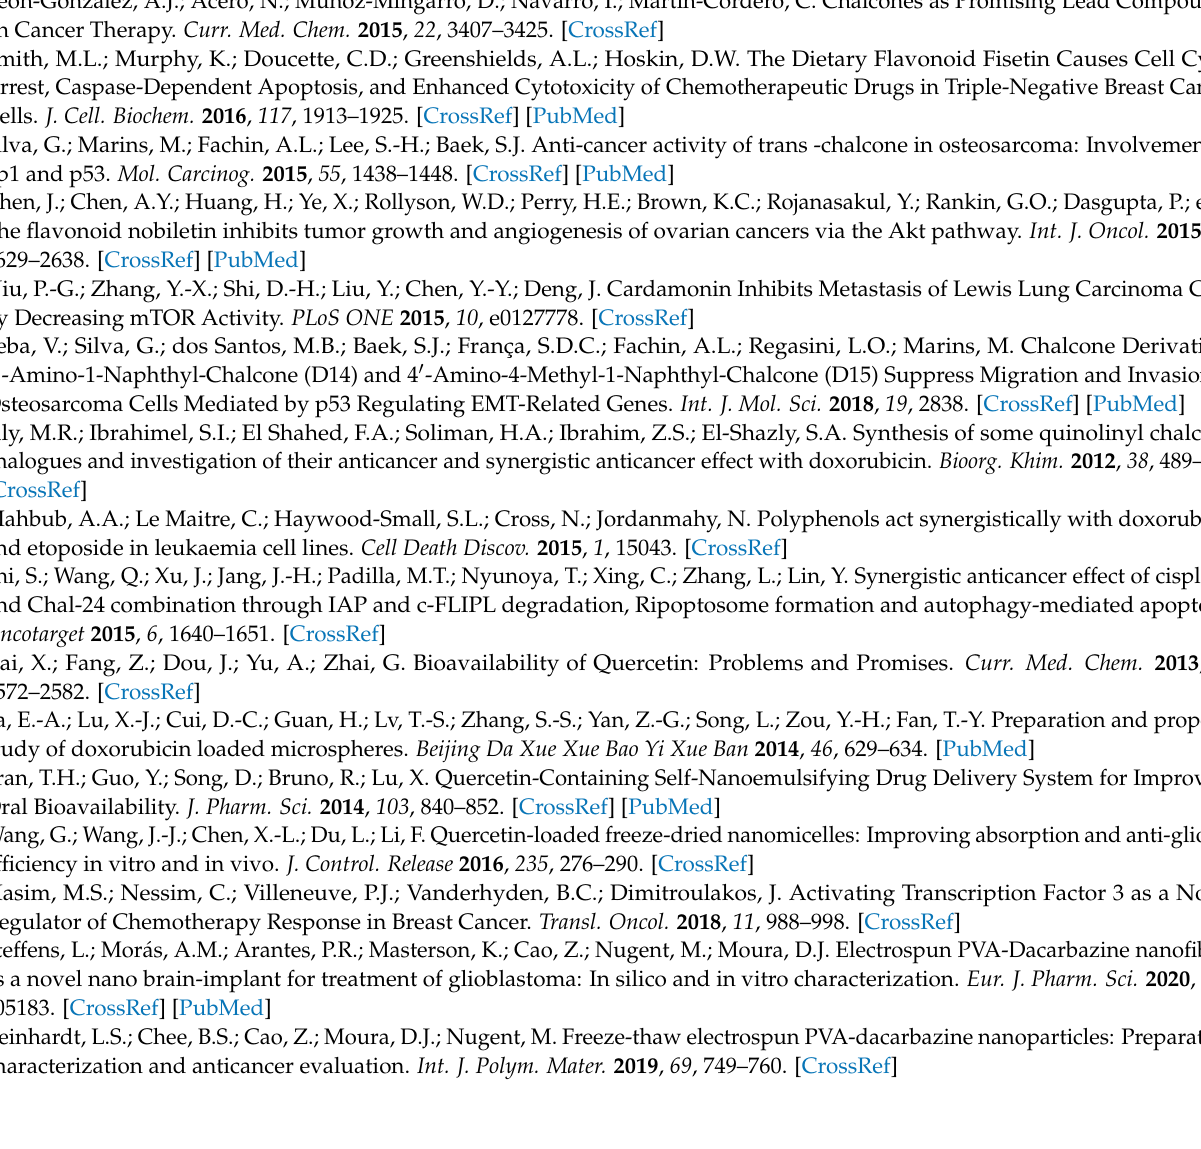
Figure A5. Cell viability inhibition after exposure to doxo, D14 and the combination of both drugs. Data is shown as mean and standard deviation.